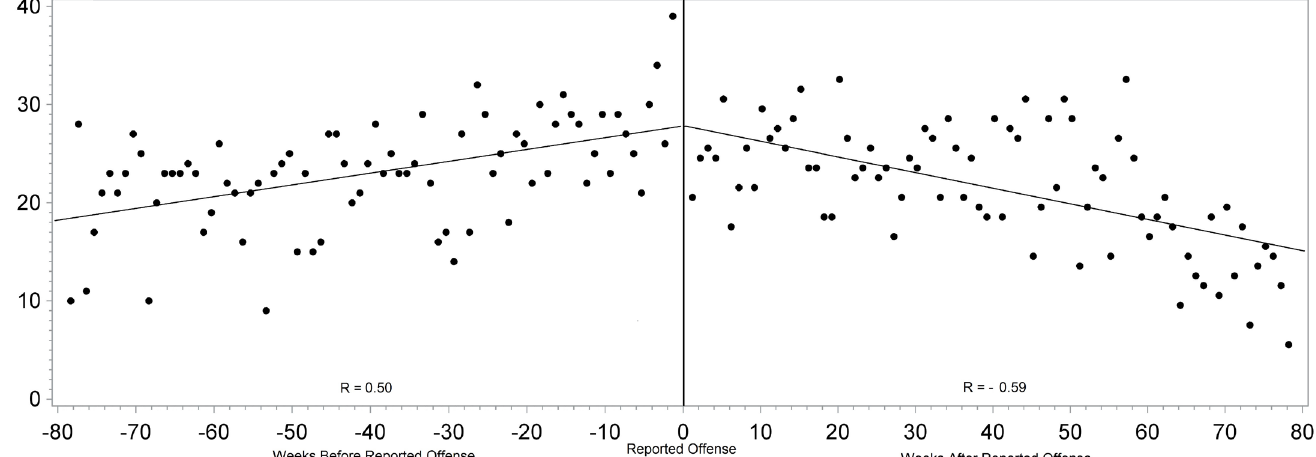
Figure 2. Correlation between number of emergency department visits and the time from each victim’s reported date of